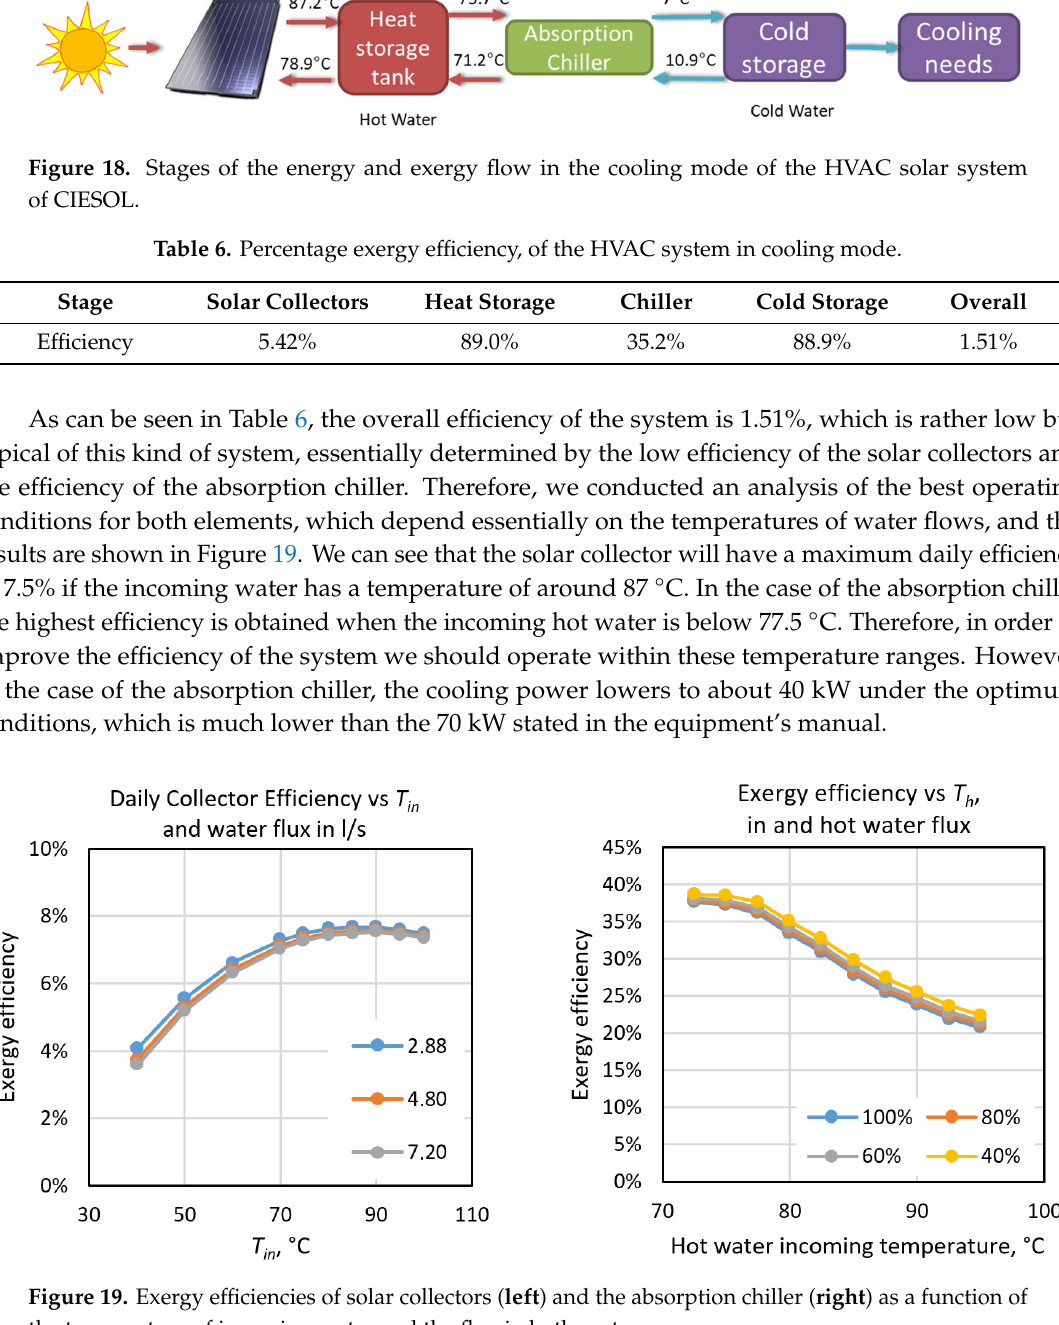
Figure 20. Final results of exergy analysis of the HVAC system with and without PCMs. As can be seen Figure 20, the introduction of S83 PCM in the system lowers the efficiency of heat storage from 89.0% to 85.6%, and the introduction of S10 lowers the efficiency of cold storage from 88.9% to 61.6%. This lowering of efficiency is due to the fact that the introduction of PCMs implies additional operations of heat transfer for charging and discharging the PCMs that produce additional irreversibilities in the whole process, the effect is more pronounced in the case of S10 PCM because it operates closer to room temperature. However, the PCMs allow more exergy to be stored in a smaller volume, e.g., instead of about 10 m 3 of hot water in a tank, a 3 m 3 tank with S83 would be enough. This analysis indicates that a good option would be to use S83 to store heat and water at 7 °C to store cold. Under these conditions the overall theoretical efficiency would be about 2.35%, which represents a 55.6% increase in the overall efficiency when compared to the present situation.